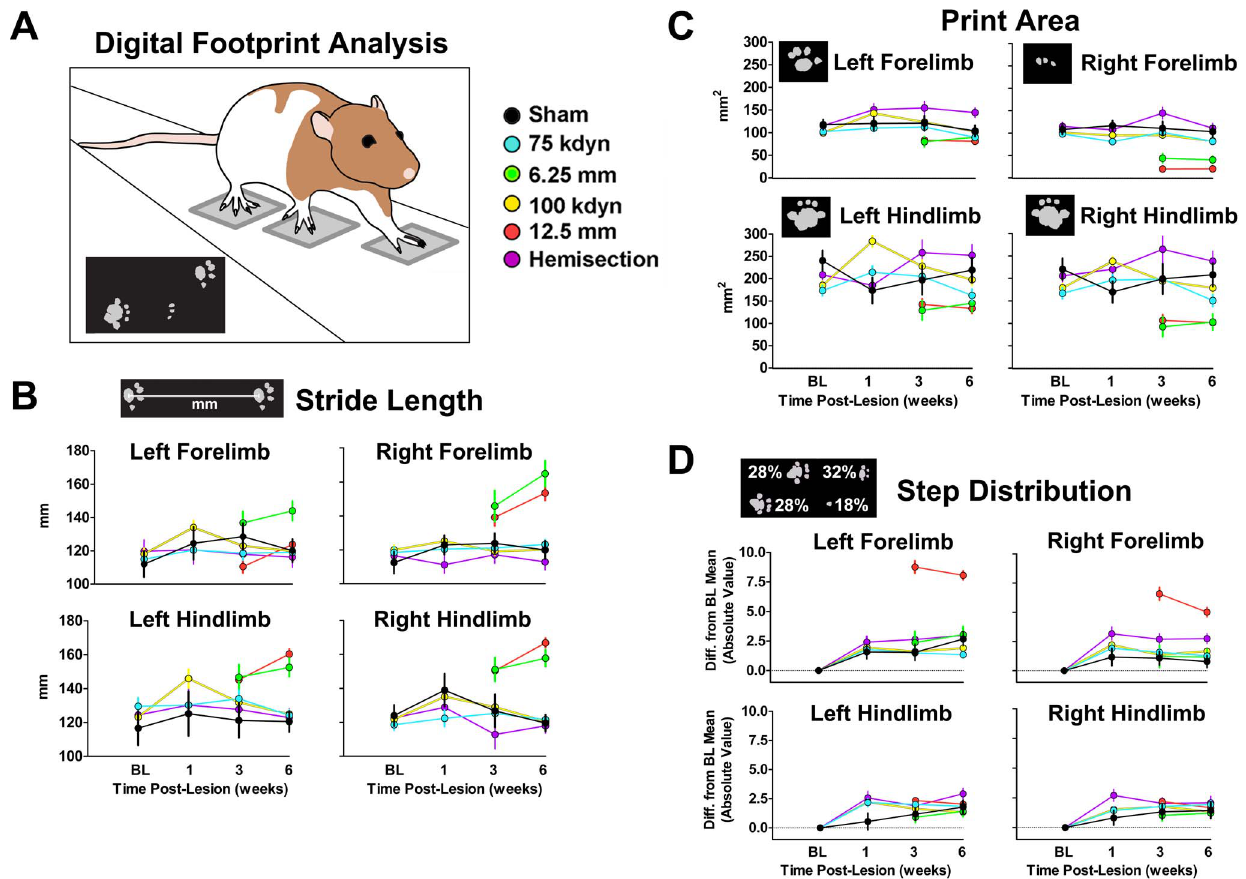
Figure 2. Standardized digital locomotor analysis for evaluating recovery after spinal cord injury in rodents. A, Digital footprint analysis allows objective quantification of many correlated outcomes including: B, Stride-length for each limb; C, Print area for each limb; D, Distribution of limb use reflected as the absolute deviation from the pre-injury baseline (i.e. deviation from , 25% recruitment for each limb).